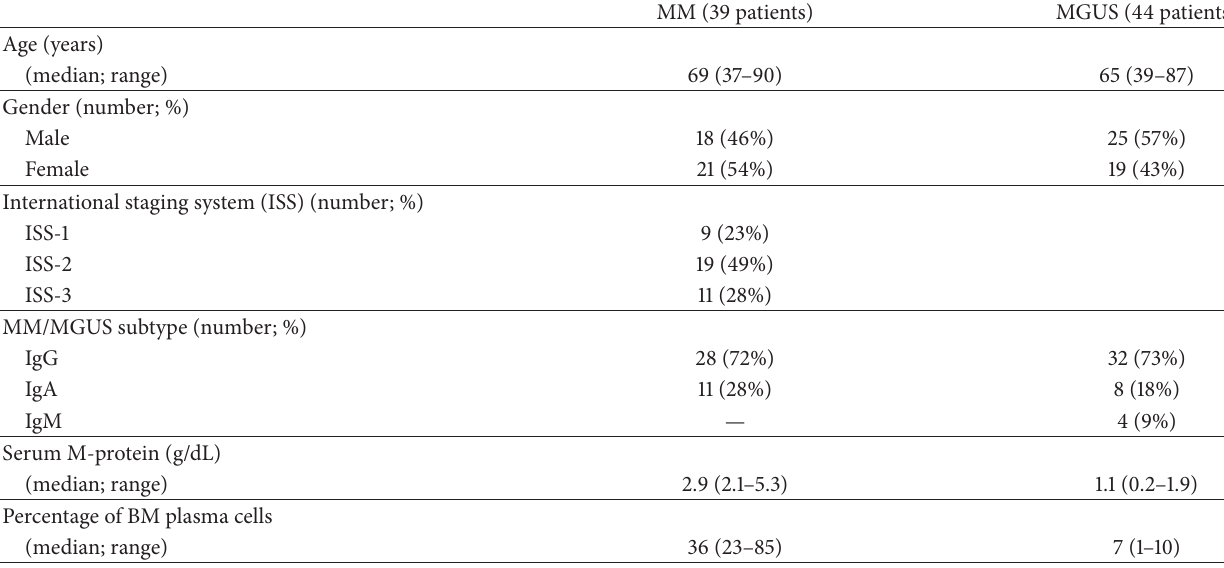
Table 1: Main patients’ characteristics at study